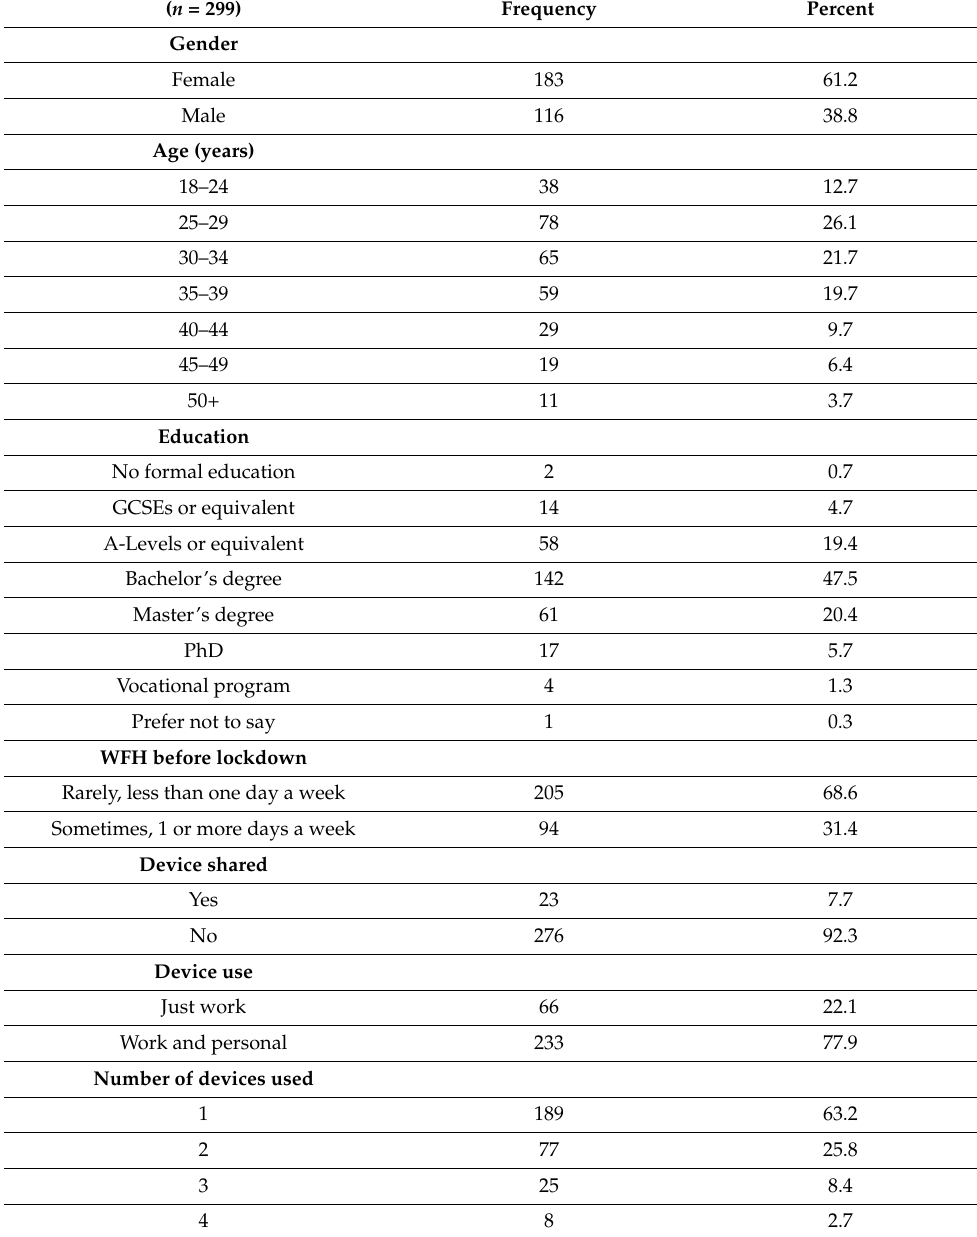
Table 1. Demographics of the